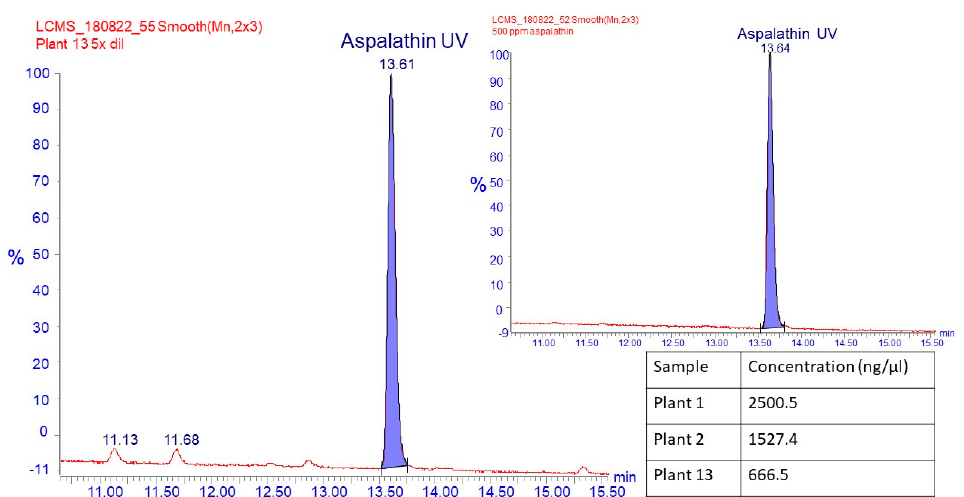
Figure 2. The chromatogram is the UPLC-MS chromatogram comparing TLC silica extracts of plants 1, 2 and 13 at RF = 0.46 to the aspalathin standard (insert). The table shows the concentrations of aspalathin extracted by the preparative TLC extraction method.